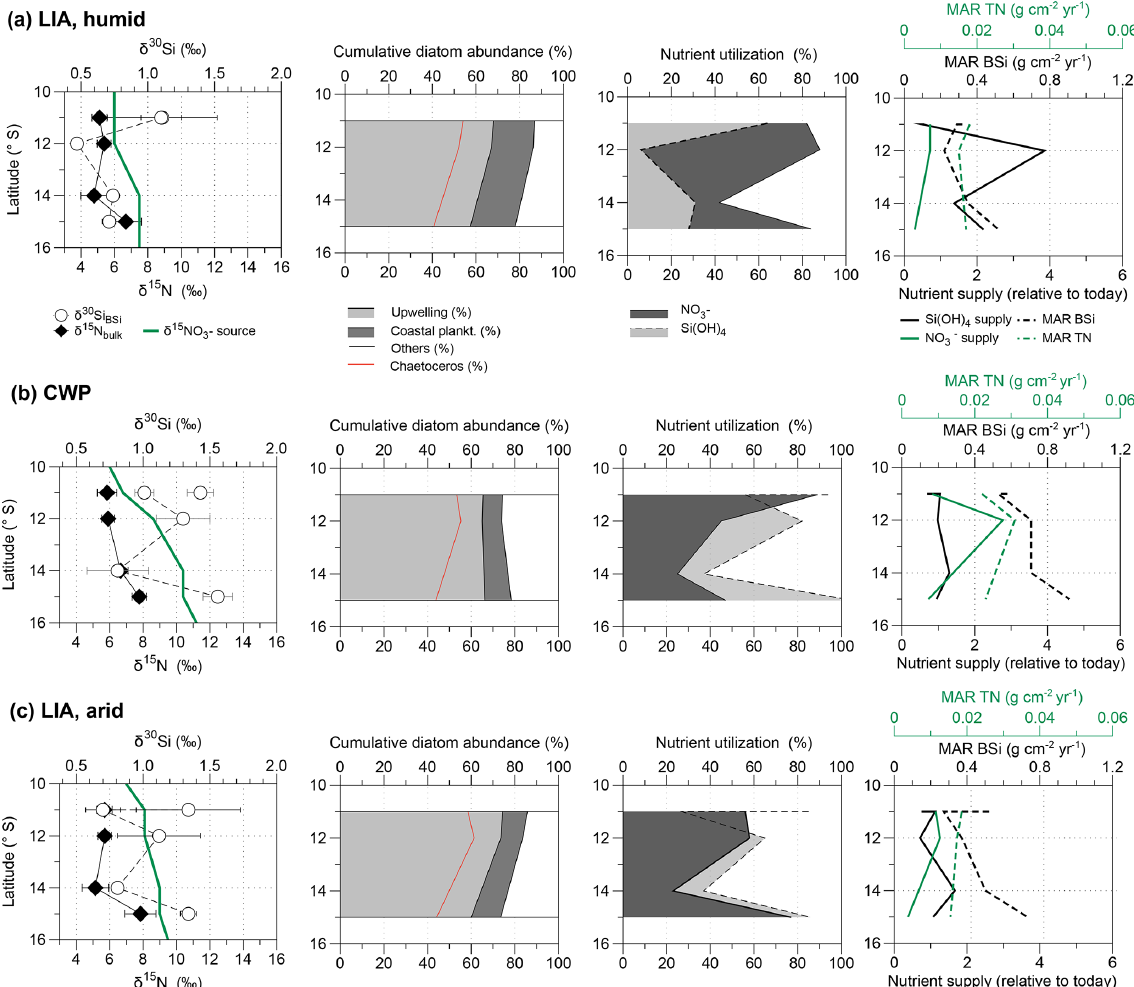
Figure 6. Latitudinal comparison of (from left to right) mean δ 15 N bulk (‰, black diamonds) and δ 30 Si BSi (‰, white circles) and the calculated δ 15 NO − source values (green line); the mean cumulative diatom abundance (%; calculated from Fleury et al., 2015); the respective 3 nutrient utilization of NO − (grey, solid line) and Si ( OH ) 4 (dashed area and line); and MAR TN (gcm − 2 yr − 1 ) and MAR BSi (gcm − 2 yr − 1 ), 3 together with nutrient supply relative to today for (a) the humid phases of the LIA, (b) the CWP, and (c) the arid phases of the LIA. Please note that for δ 15 N bulk values the mean was calculated for all available values for each time period and not only for samples for which δ 30 Si BSi values are also available. Error bars mark the 1SD of the mean